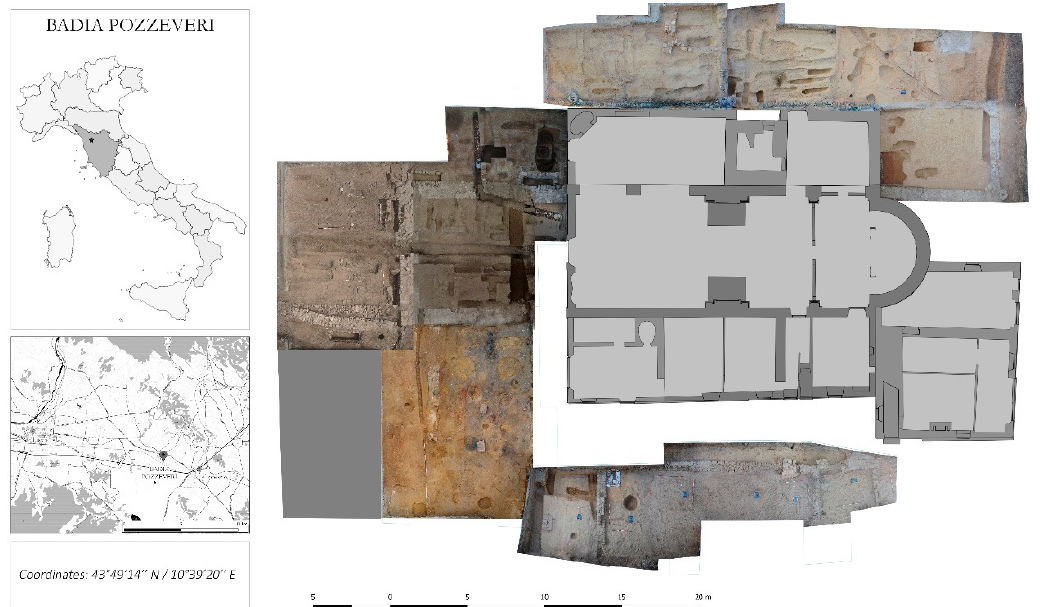
Figure 1. Geographical location and archeological site of San Pietro di Pozzeveri in the village of Badia Pozzeveri. On the left, geographical location of the archaeological site, which is located about 10 km southeast of the city of Lucca (Tuscany, Italy). On the right, representation of the archaeological excavation, which was conducted by the “open area method”.